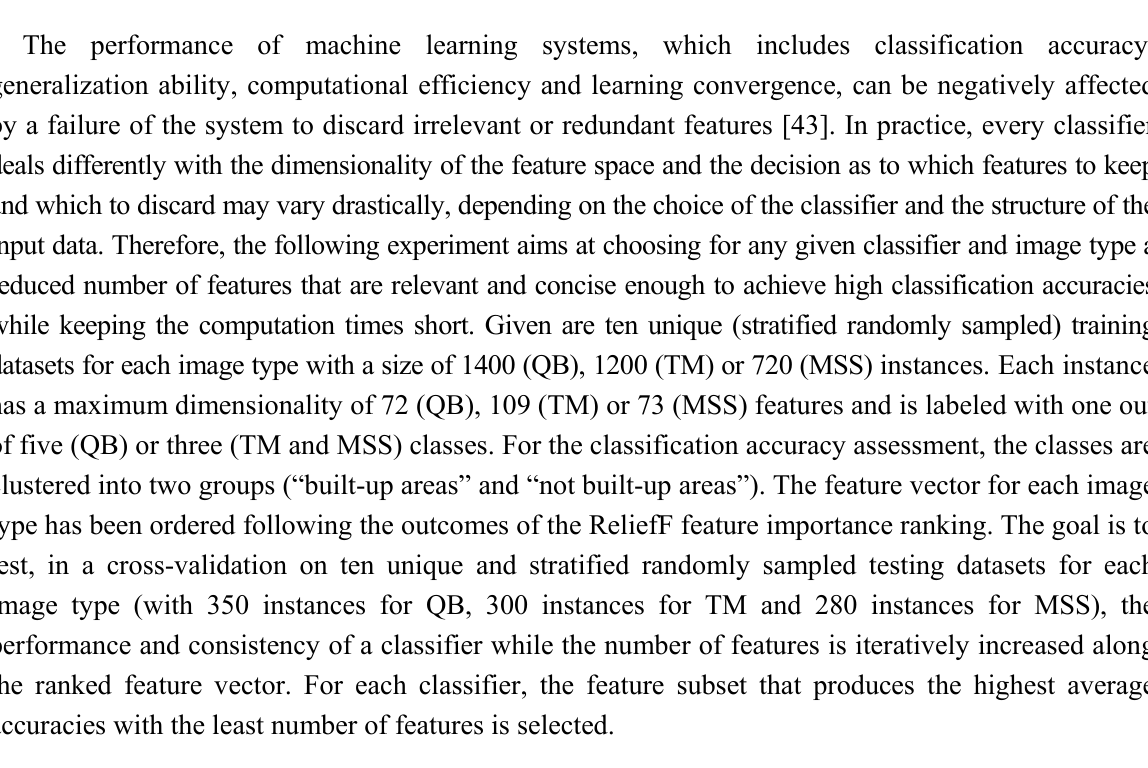
Figure 3. ROC curves for the classification of QB, TM and MSS, depicting the performance of different classifiers under varying sizes of the feature